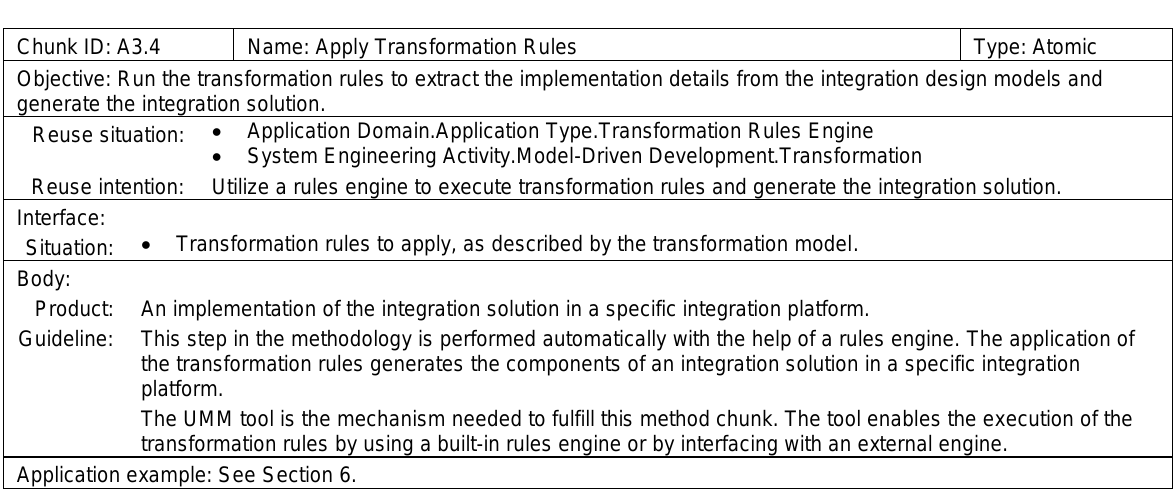
Table 11. Definition of method chunk